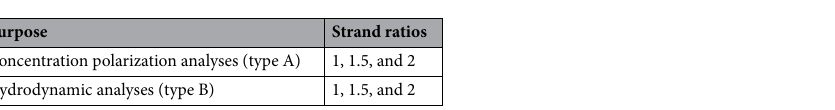
Table 1. Summary of studies